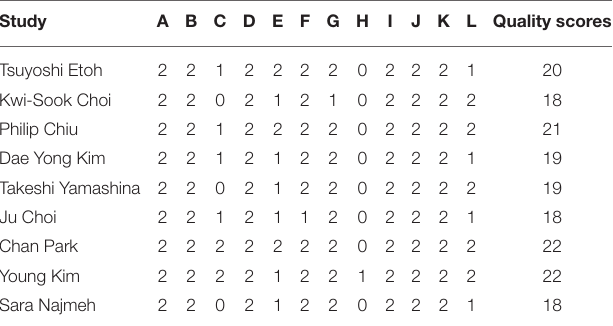
TABLE 2 | Quality scores of the included clinical studies were assessed by the Methodological Index for Nonrandomized Studies (MINORS). Study